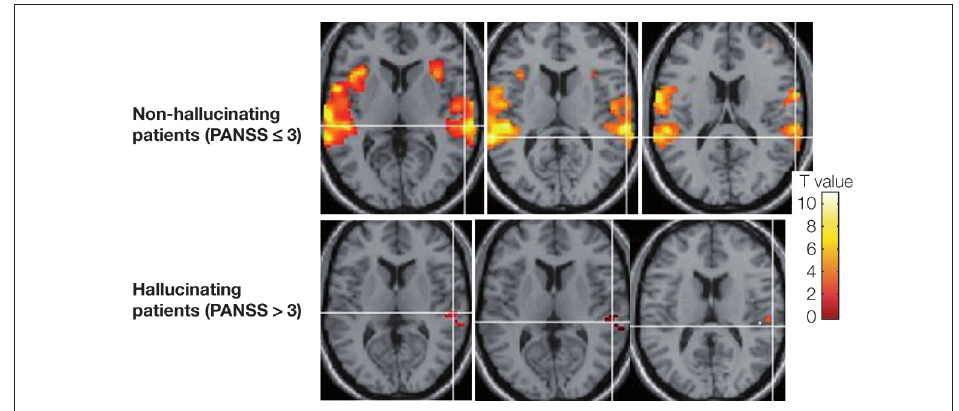
Figure 3 | fMRI activation data shown in three axial slices above the anterior–posterior commissure (AC–PC) midline in non-hallucinating (upper row) and hallucinating patients with schizophrenia when listening to dichotic presentations of speech sounds. Note the absence of significant activation in the left temporal lobe in the hallucinating patients ( p < 0.001,